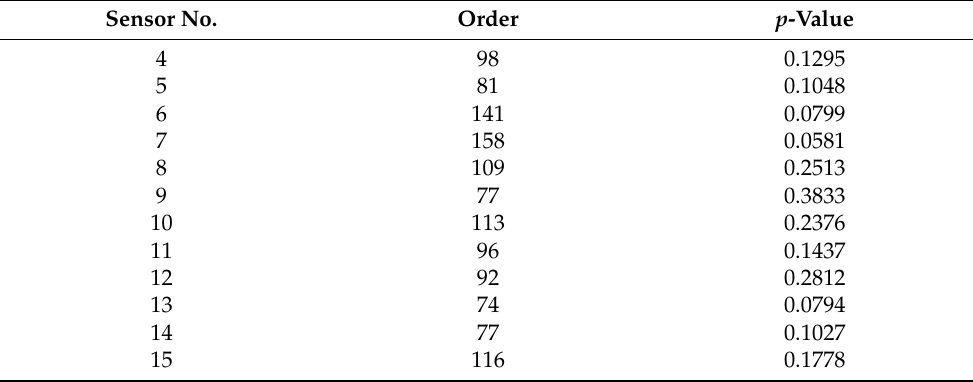
Table 4. ASCE problem: AutoRegressive (AR) orders and relevant p -values obtained via the LBQ test for each sensor location in Case 1.